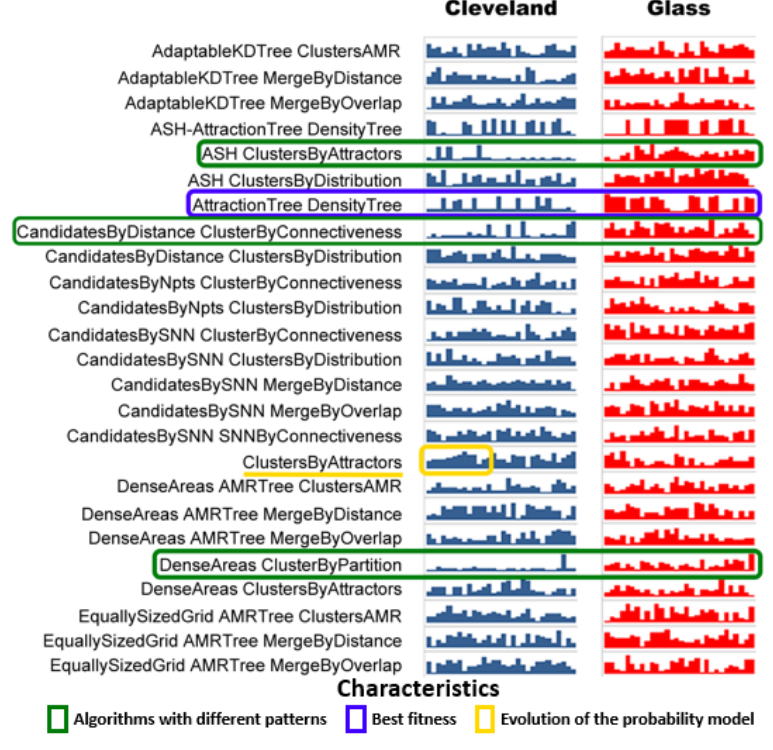
Figure 11. Histogram matrix of the algorithm occurrences for the Cleveland Heart Diseases and the Glass Identification